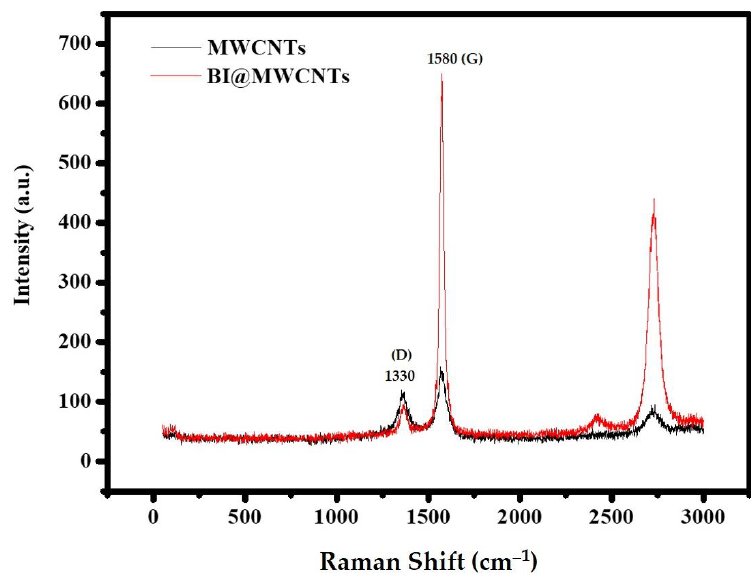
Figure 3. Raman spectra of MWCNTs – CO 2 H and BI@MWCNTs.